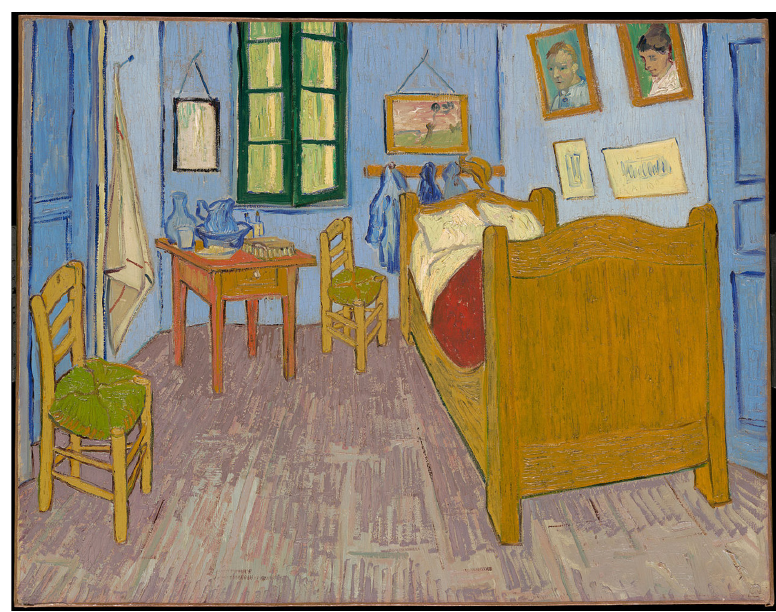
Fig. 1 : Vincent Van Gogh, Bedroom in Arles , 1889, oil on canvas, 57.3 × 74 cm, Musée d’Orsay, Paris. Wikimedia